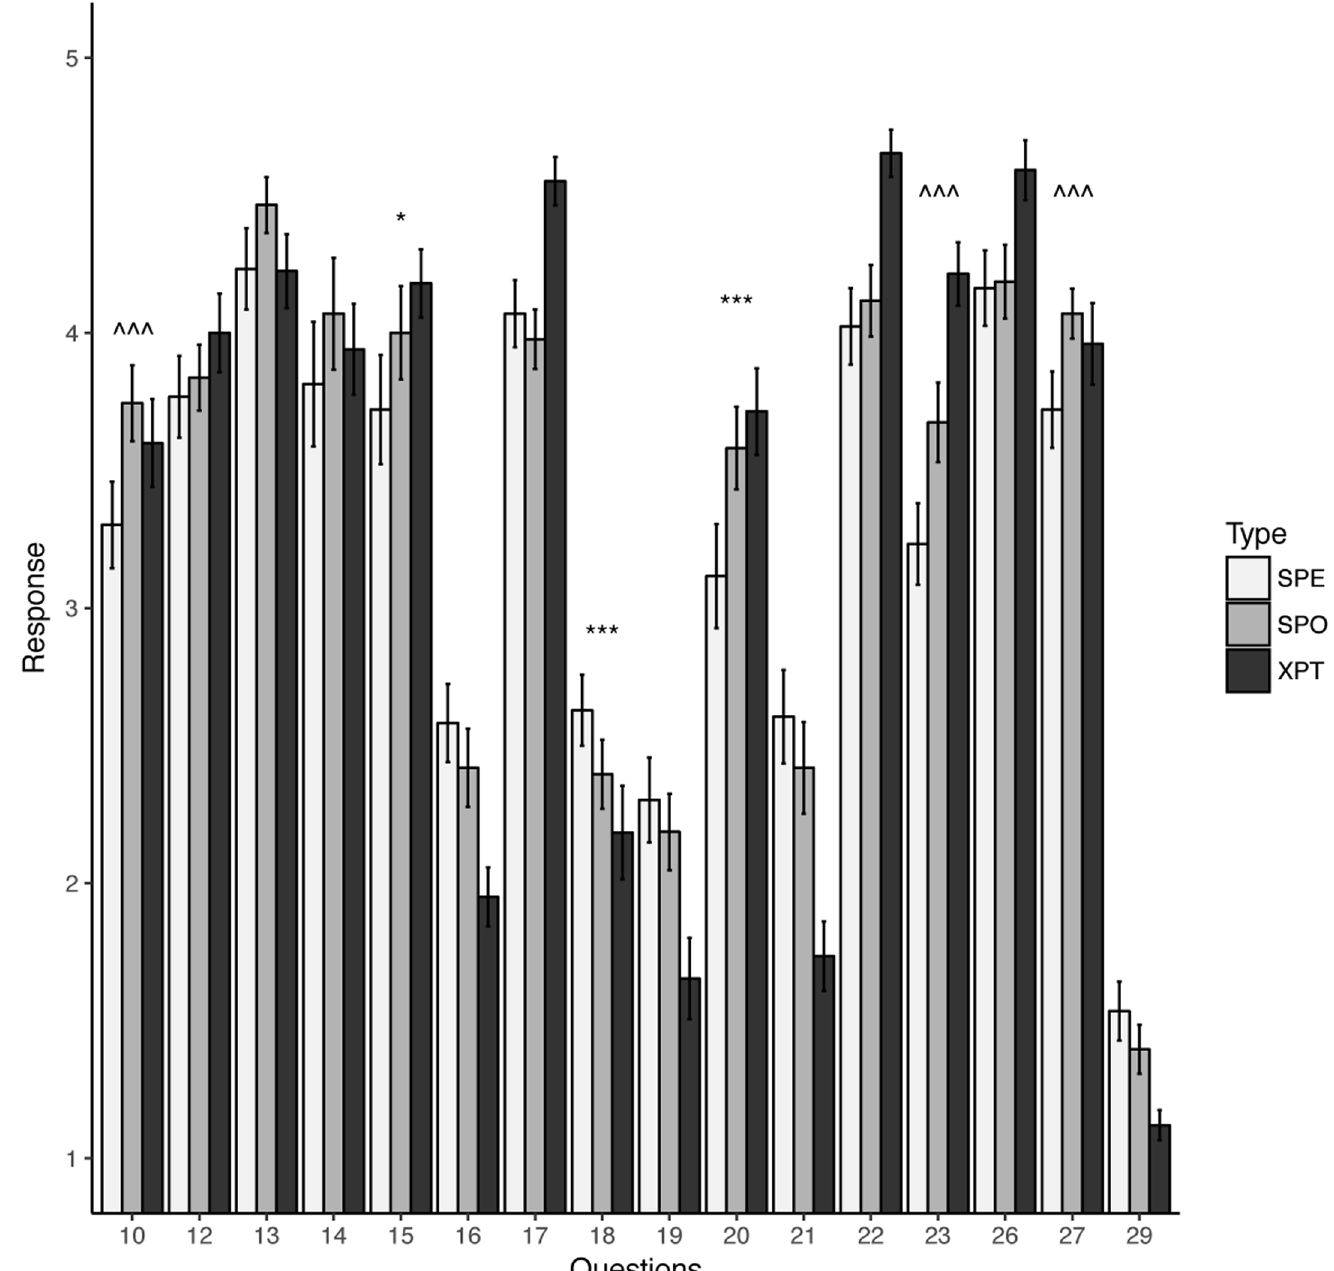
Fig 3. Student and expert answers to a selection of questions from the pre- and postmodule questionnaire. Student and expert responseswere filtered as describedin the Methods. Student responses were comparedbefore module participation and after moduleparticipationusing a paired t test. Student responsesboth pre and post modulewere also individuallycomparedto expert responses using t tests. Error bars reflect SE. If student responses before the module comparedwith expert responses were statistically significantly different (at p < 0.05), and postmodulestudent responses were no longerstatistically significantly different from expert responses (at p < 0.05), then the questionwas marked *** . If student responses before the modulecomparedwith expert responses were statistically significantly different (at p < 0.1), and postmodule student responses were no longer statistically significantly different from expert responses (at p < 0.1), then the question was marked * . If student responses before the module compared with student responsesafter the modulewere statistically significantly different from expert responses (at p < 0.05), then the question was marked ^^^. N (students) = 51; N (experts) = 50. A complete list of the questionscan be found in Supportinginformation. SE, standard error; SPE, student response pre module;SPO, student responsepost module; XPT, expert